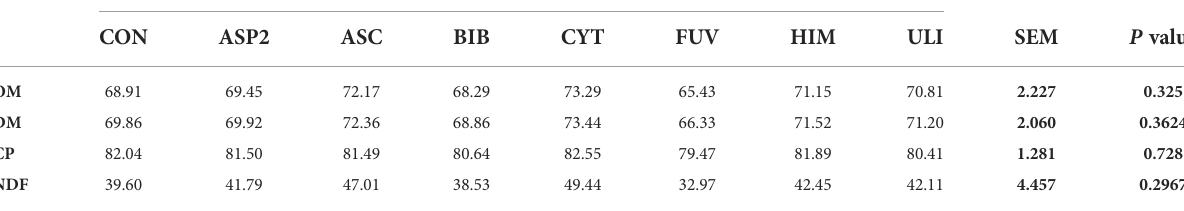
TABLE 4 Effect of seaweed inclusion on nutrient disappearances (Experiment 2) in the